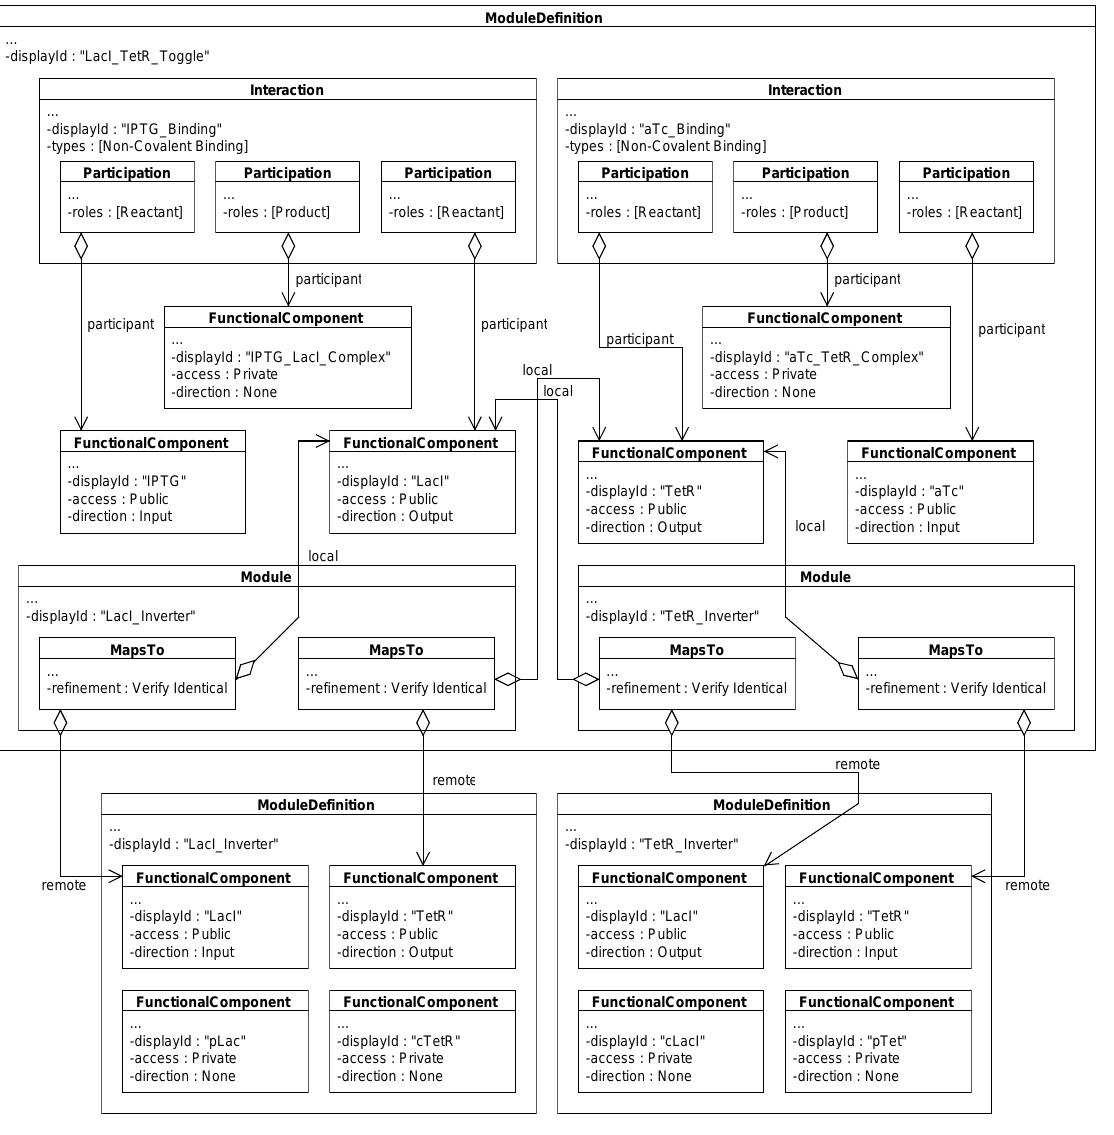
Figure 32: Composite ModuleDefinition of the LacI/TetR toggle switch. This ModuleDefinition contains the Module objects that instantiate LacI and TetR inverter ModuleDefinition objects. It also contains FunctionalComponent objects that instantiate the ComponentDefinition objects for the LacI/TetR transcription factors and IPTG/aTc small molecules. These FunctionalComponent objects each participate in a non-covalent binding Interaction . To com- plete the composition of the toggle switch, MapsTo objects are used to indicate that the output of the LacI inverter ModuleDefinition is identical to the input of the TetR inverter ModuleDefinition and vice